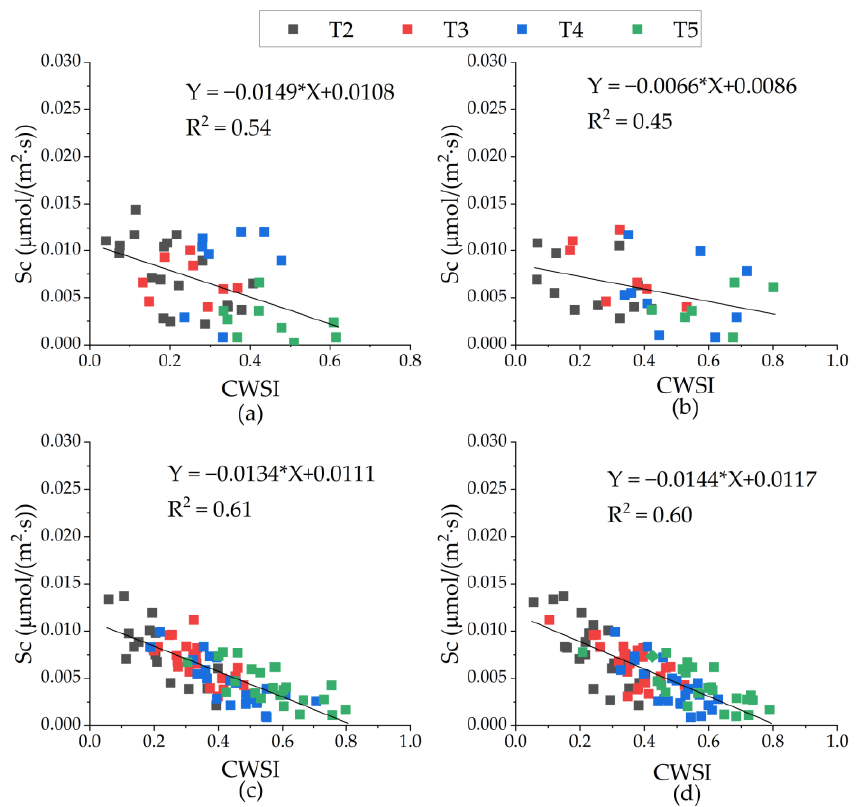
Figure 13. Relationship between Sc and the CWSI based on the ( a ) measured and ( b ) predicted 𝑇 𝑤𝑒𝑡 and 𝑇 𝑑𝑟𝑦 of E1 and the CWSI based on the ( c ) measured and ( d ) predicted 𝑇 𝑤𝑒𝑡 and 𝑇 𝑑𝑟𝑦 of E2.